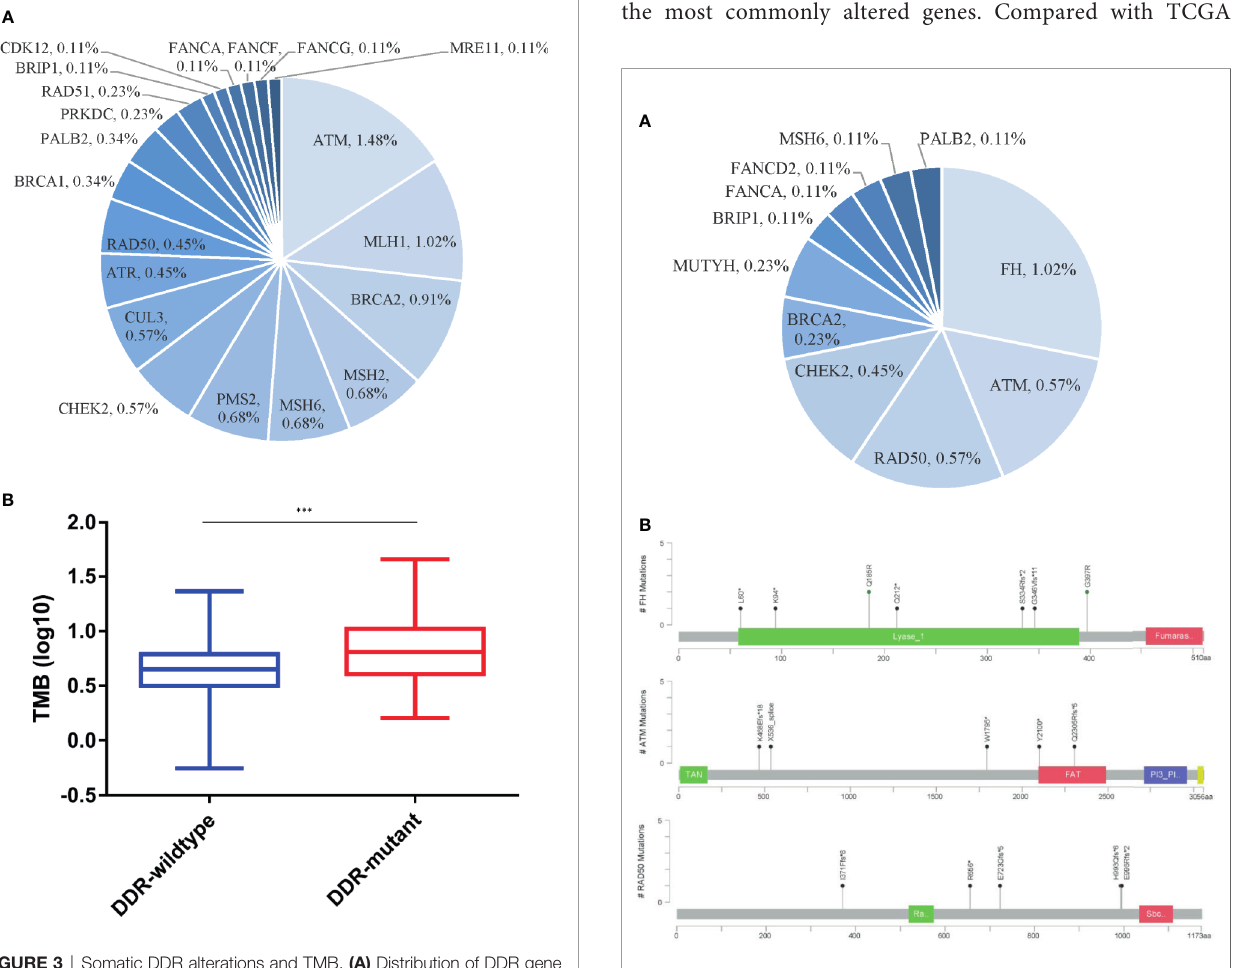
FIGURE 4 | Pathogenic germline variants in Chinese clear cell renal carcinoma. (A) Distribution of pathogenic germline mutations. (B) Locations of pathogenic germline mutations in the top three frequent germline mutant genes.